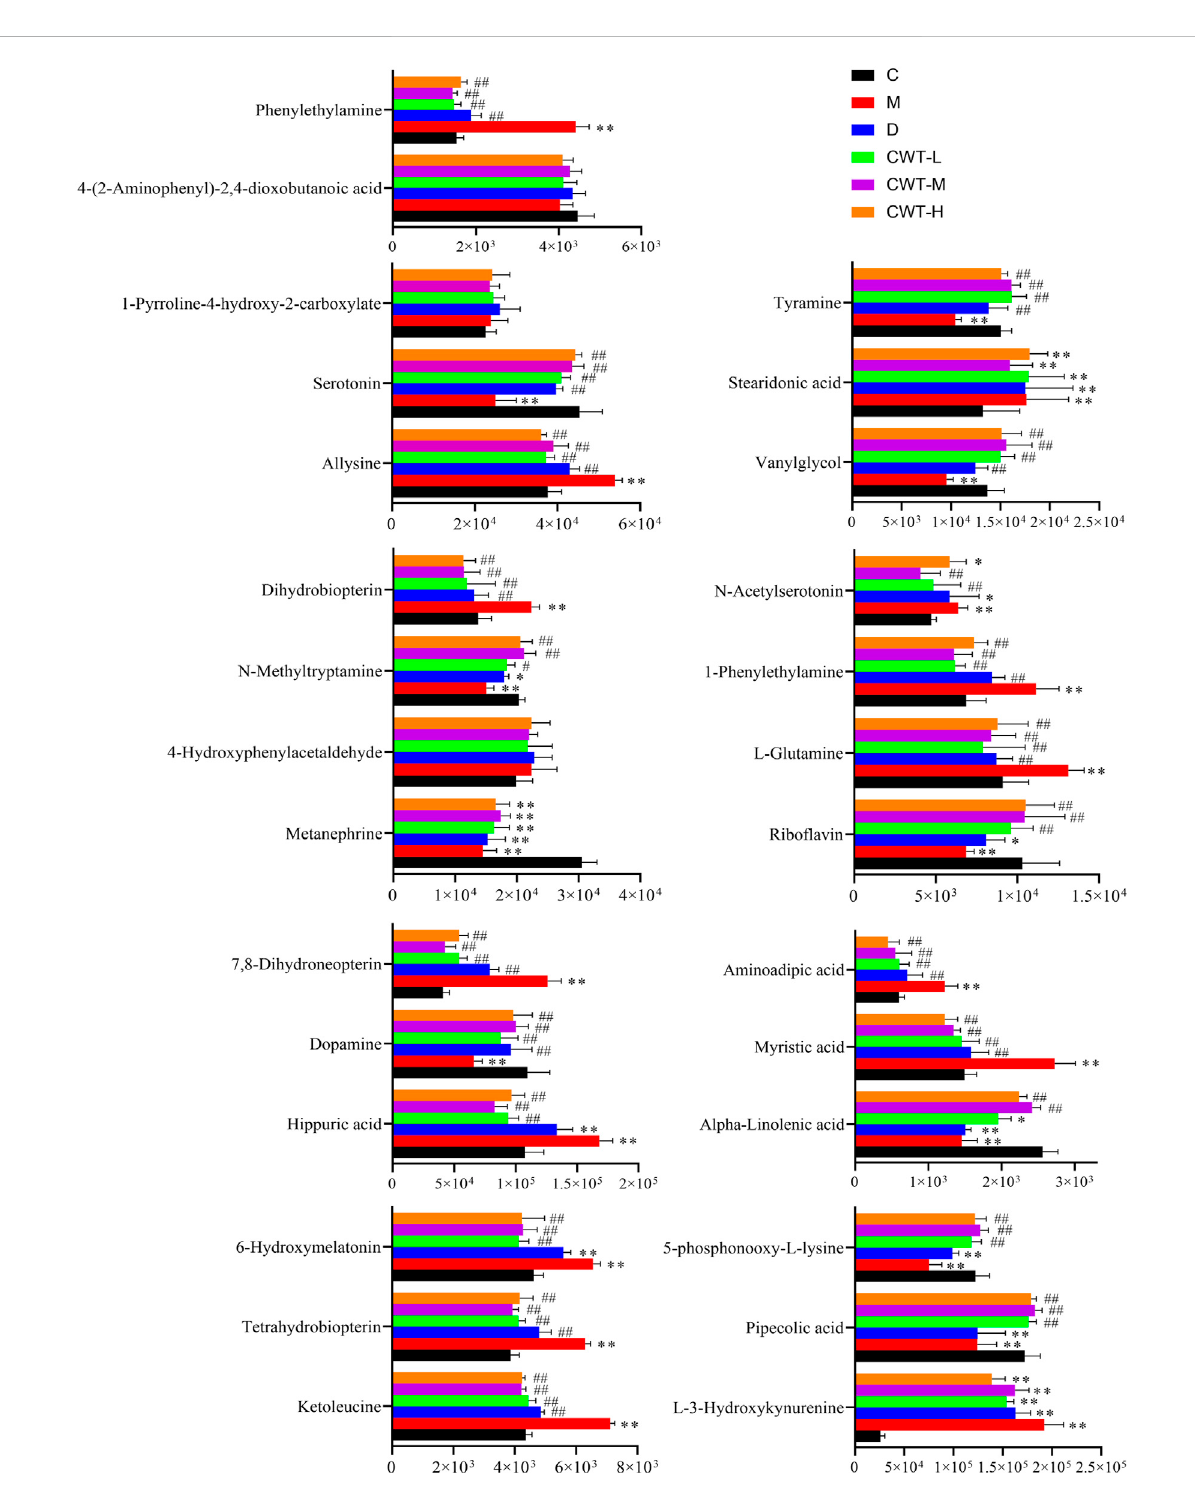
FIGURE 10 Changes in the content of insomnia biomarkers in each group after treatment. (C, control group, n = 10; M, model group, n = 10; D, diazepam group, n =10;CWT-Lgroup, n =10;CWT-Mgroup, n =10;CWT-Hgroup, n =10;comparedwiththeCgroup,* p < 0.05,** p < 0.01; compared with the M group, # p < 0.05, ## p < 0.01, mean ±